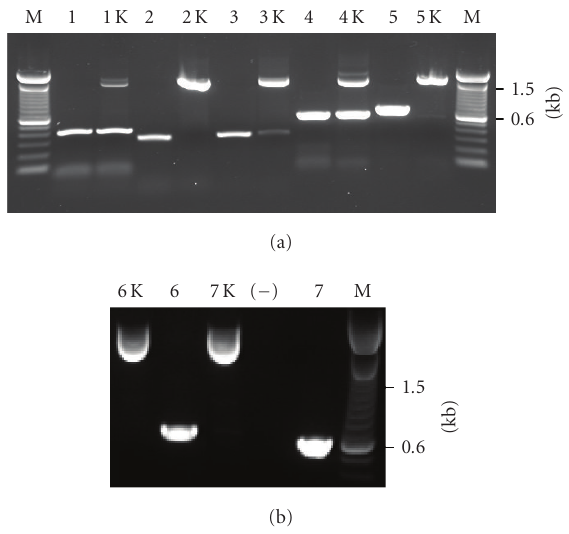
Figure 4: PCR analysis of 7 BAC clones before and after targeting. Kanamycin-resistant clones (lanes 1–7) were found by targeted recombination screening of the library. The corresponding “origi- nal” clones (“1–7 k” lanes) were identified from the arrayed library by radioactive probe screening and served as a control. All clones were screened with gene-specific primers flanking the putative integration site. Lanes 1 through 7 show candidate BACs identified for EMS1, MGC, SKB1, GMPPA, FLJ20539, NFAT5, and GRIA3, respectively. As anticipated, in all seven cases, the size of PCR product was larger than 1.3-Kb compared to the alleged original clone.